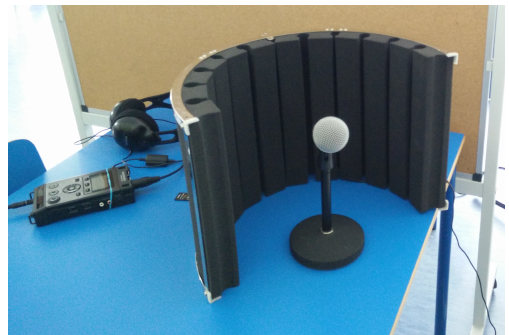
Figure 2. Equipment used for the recordings: a digital audio tape (DAT), a microphone, and acoustic foam.